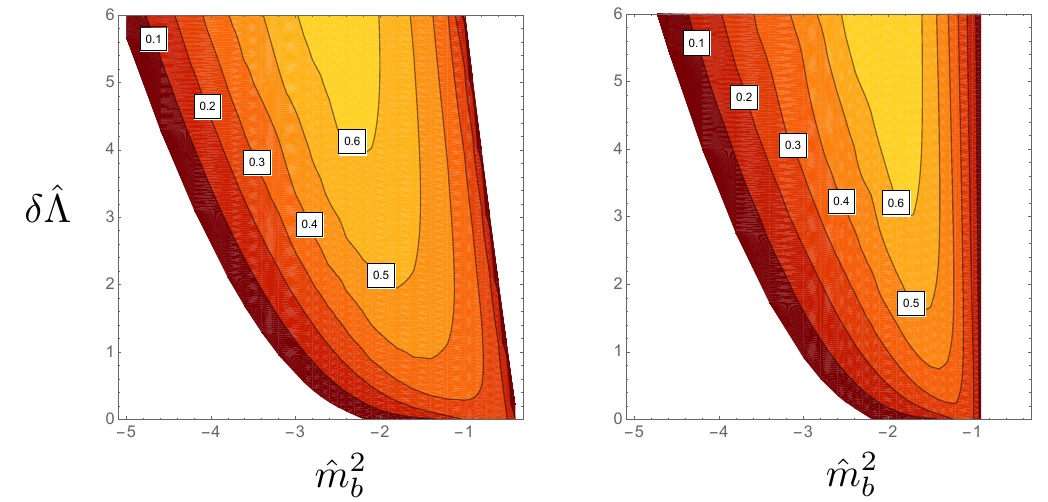
Figure 3 . Region of the parameter space that leads to a stable IR-brane for ^ (cid:20) 2 = 4 and (cid:21) = 1 (left) and (cid:21) = (cid:0) 1 (right). We also provide the value of the lightest scalar mass, m S